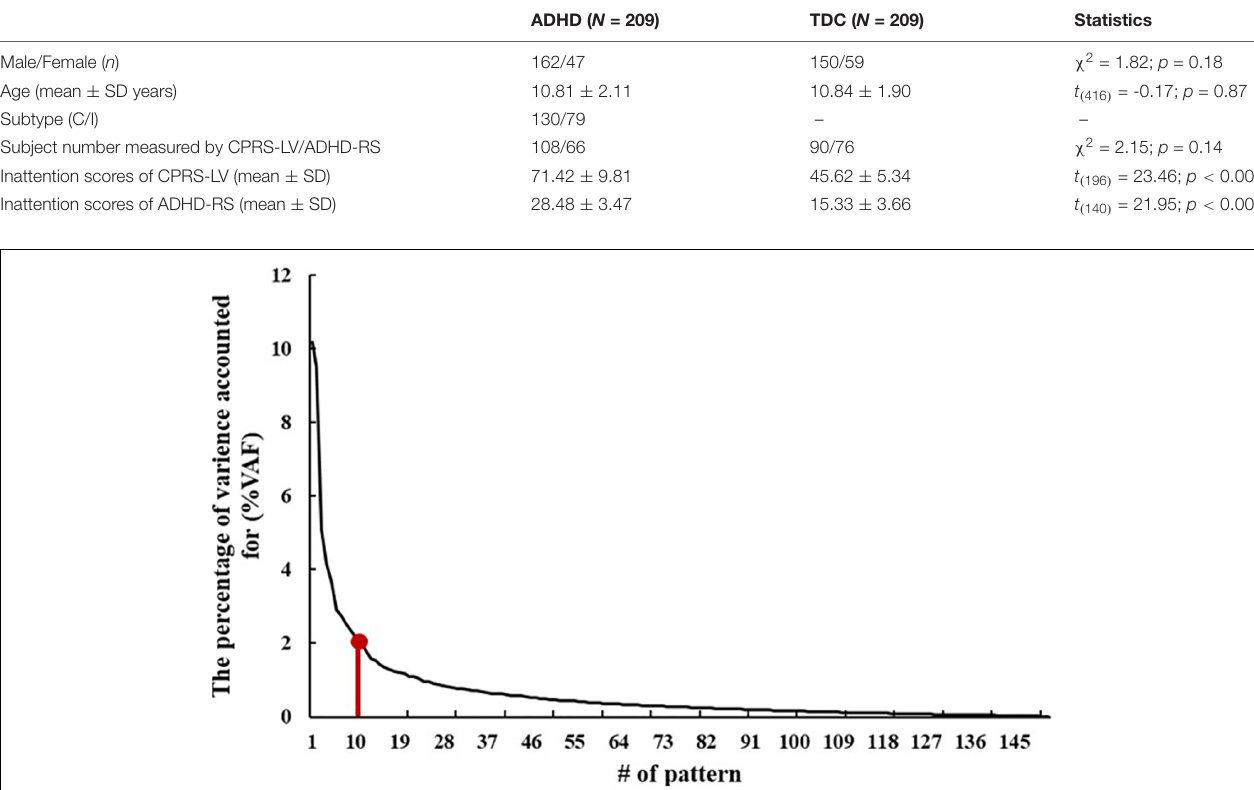
TABLE 1 | Demographic information of all the participants (ADHD, attention deficit hyperactivity disorder; TDC, typically developing control subject; C, ADHD-Combined; I, ADHD-Inattentive; CPRS-LV, Conners’ Parent Rating Scale long version; ADHD-RS, DuPaul ADHD Rating Scale IV).